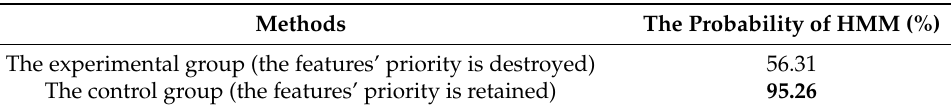
Table 1. Comparison of two feature sequences in different order.